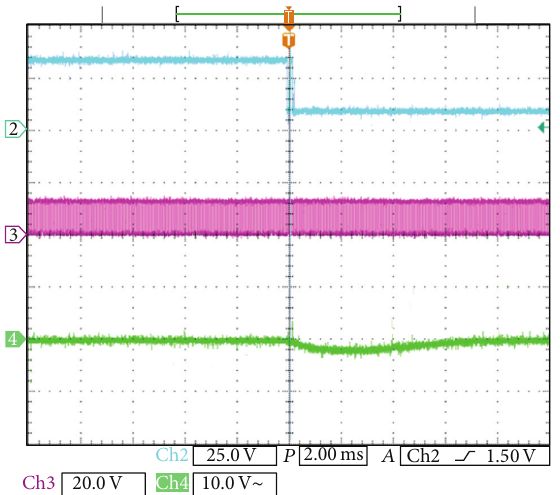
Figure 20: Operation under a load variation from top to bottom: triggering signal, 𝑆 2 , and 𝑉 𝑜 (AC